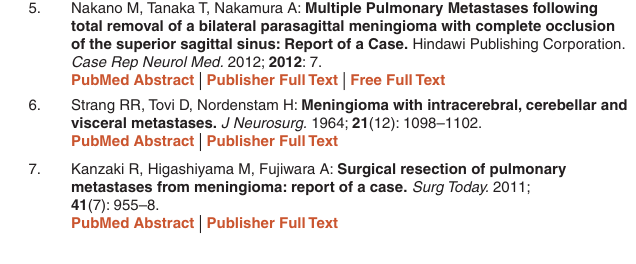
Figueroa BE, Quint DJ, Mckeever PE: Extracranial metastatic meningioma. Br J Radiol. 1999; 72 (857):